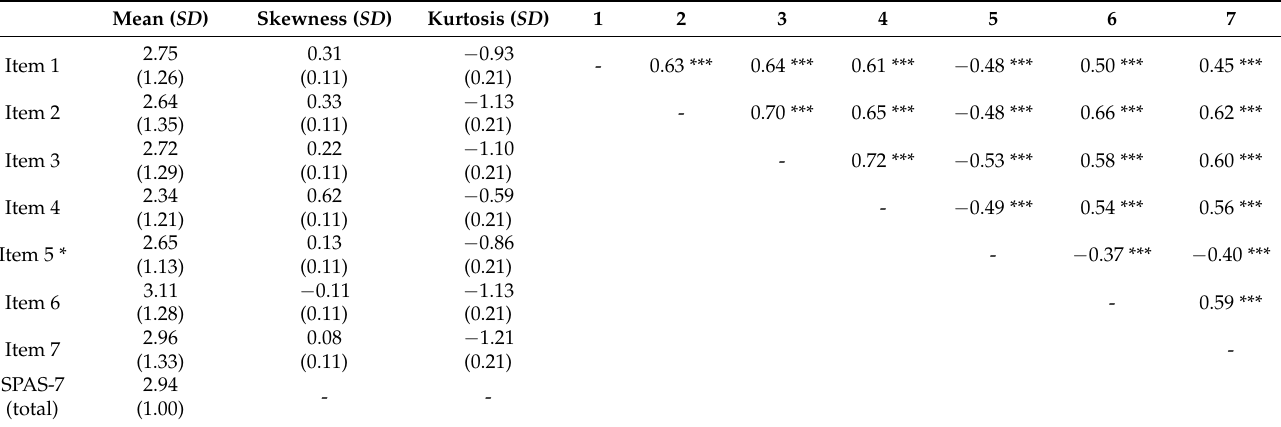
Table 1. Descriptive Statistics and correlations of all the 7 items of the SPAS-7 ( N =